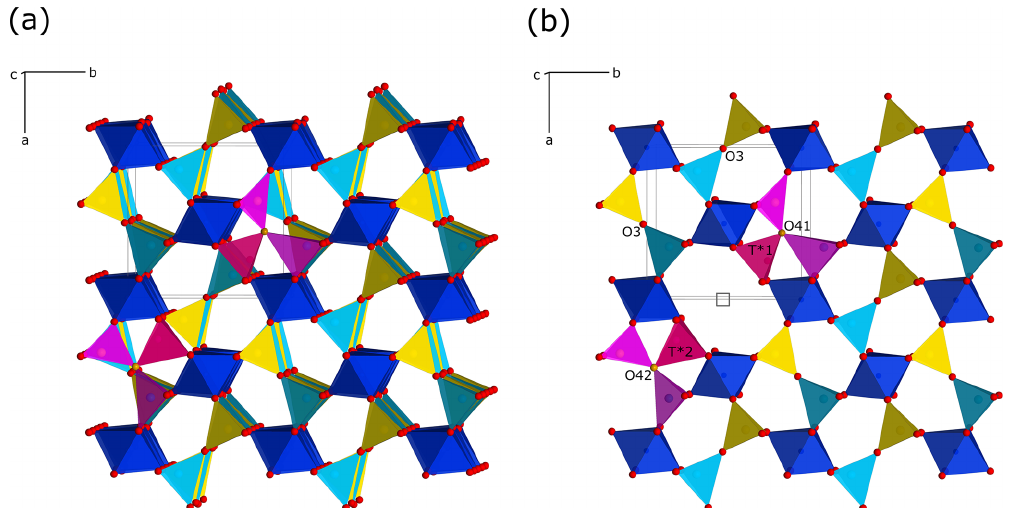
Figure 4. Crystal structure of mullite-2 c projected to the a – b plane (view direction parallel c , slightly rotated about the a and b axis). The octahedra are predominantly occupied by Al and to some extent by Fe. The blue tetrahedra are mainly occupied by Al (T1 site), and the yellow ones are mostly occupied by Si (T2 site). An oxygen vacancy is shown at 1, 1 / 2, 1. Triclusters are composed of two TO4 groups (light violet) and one T ∗ O4 tetrahedron (magenta), connected by the O41 / O42 atom (ochre). The outline of one unit cell is shown in the upper left. (a) Projection of four unit cells. (b) Representation of the uppermost layer of the structure, emphasising the oxygen vacancy.